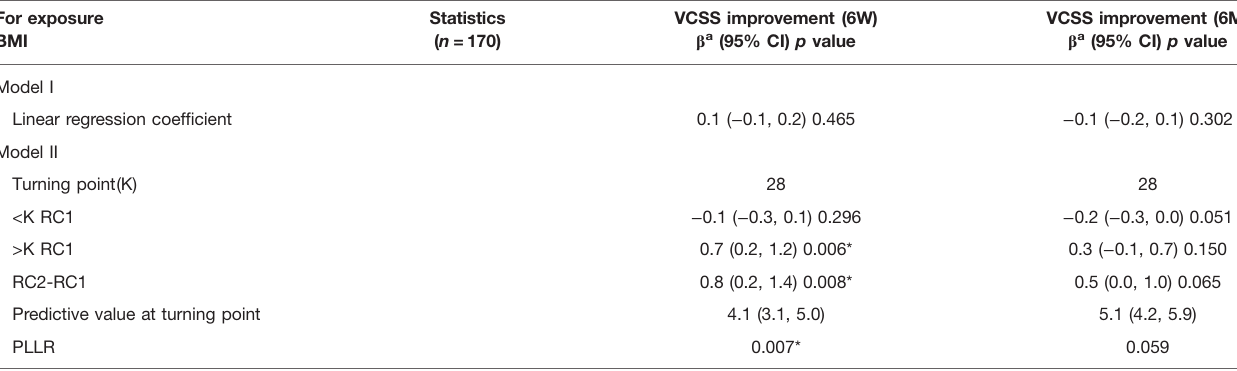
TABLE 3 | Threshold analysis for the relationship between BMI and the improvement of VCSS and AVVQ at six weeks and six months after surgery. For exposure